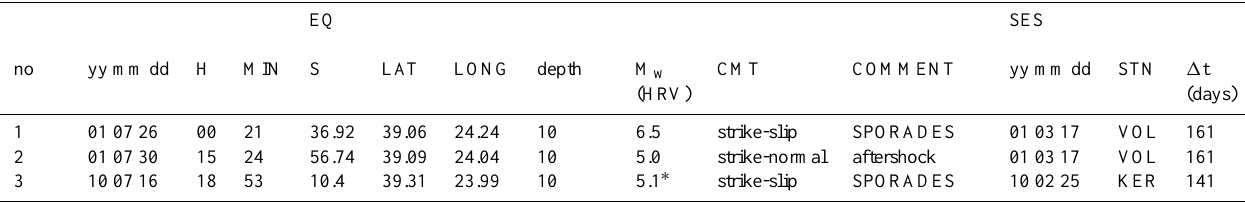
Table 1. All PDE reported earthquakes with M w ≥ 5 for the period 1 January 1995 to 18 October 2010, that occurred within the Sporades basin in the Aegean Sea along with their CMT solutions and characteristics of corresponding SES (time, station (STN) of detection and lead time, 1 t).